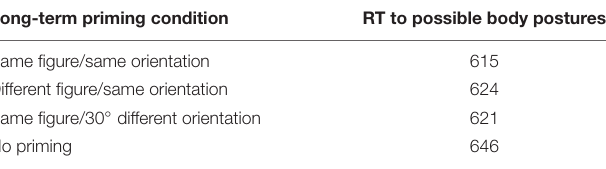
TABLE 1 | Mean identification time (in ms) of anatomically possible human postures in the test phase of Experiment 1 as a function of long-term priming